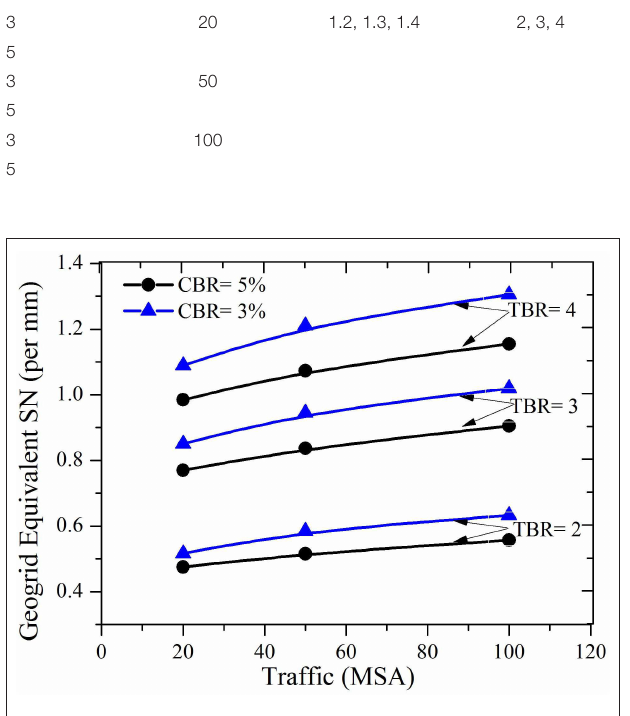
FIGURE 1 | Variation of geogrid equivalent SN of reinforced pavement with various types of subgrades and traffic for TBR equal to 2, 3, and 4.